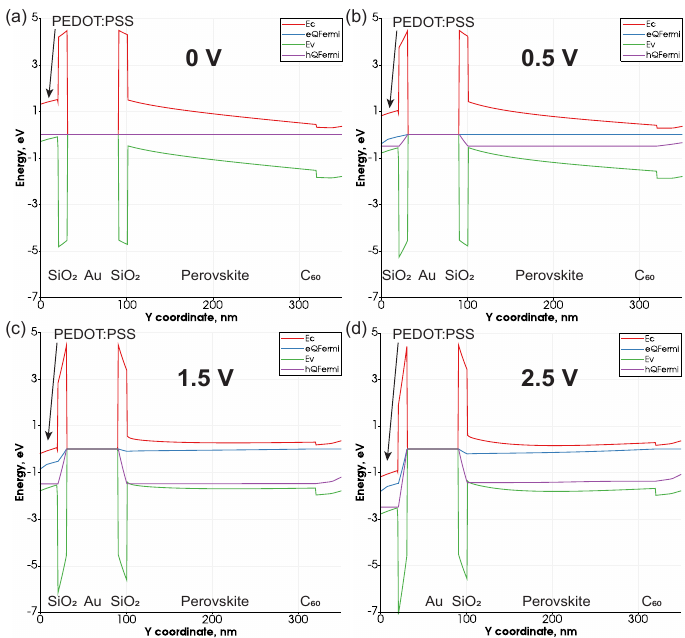
Figure 8. Energy band diagrams along the growth direction of the structure for FAPbBr 2 I device with integrated NP (60 nm diameter of gold core and 10 nm thickness of SiO 2 shell) at four different voltages: ( a ) 0 V ( b ) 0.5 V ( c ) 1.5 V ( d ) 2.5 V.